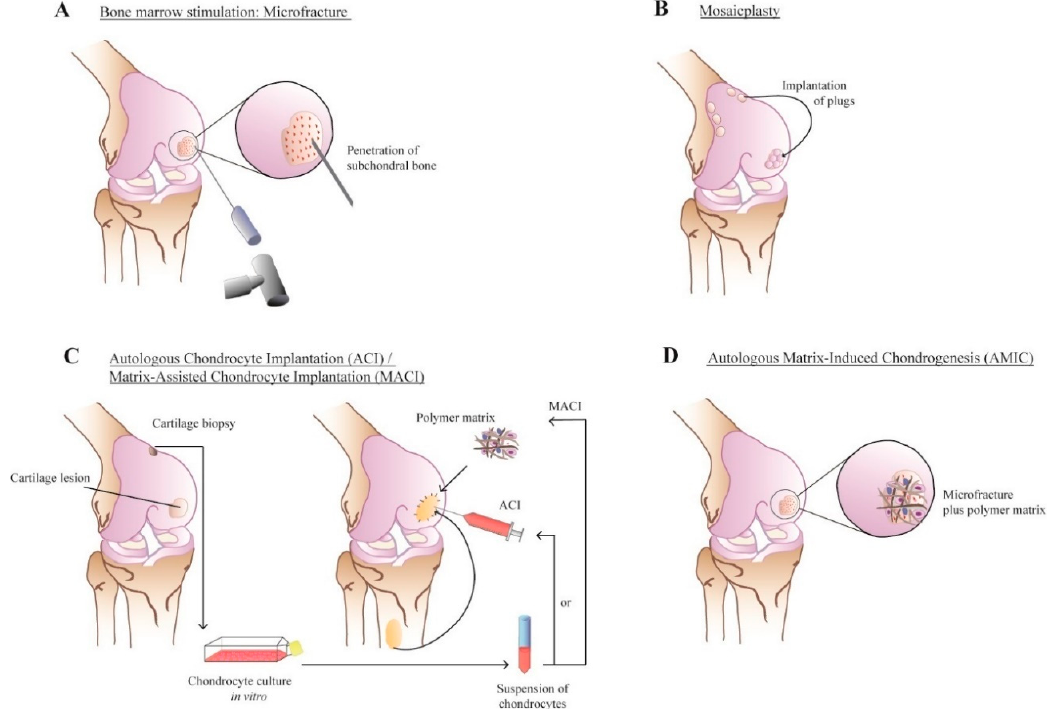
Figure 1. Schematic representation of current regenerative cartilage repair techniques: ( A ) Microfracture; ( B ) Mosaicplasty; ( C ) autologous chondrocyte implantation (ACI) and matrix-assisted chondrocyte implantation (MACI); and ( D ) Autologous matrix-induced chondrogenesis (AMIC). Reprinted with permission from Marjolein M. J. Caron [41].